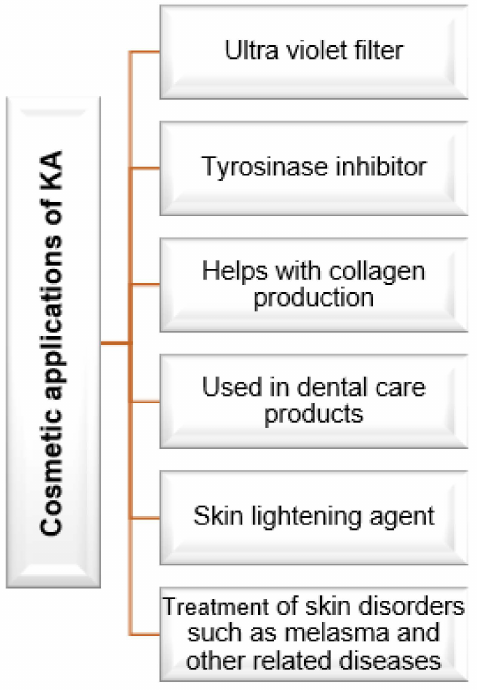
Figure 2. Cosmetic applications of kojic acid